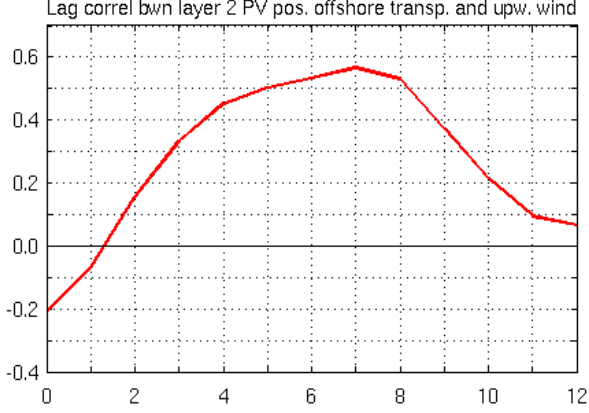
Figure 14. Lag correlation between the magnitude of along-shore wind for the northern coast of the Yucatan Peninsula and the PV positive (offshore) transport from the Campeche Bank (CB section, Fig. 14a) to the GoM interior in layer 2 (of three-layer simplified analysis of full model